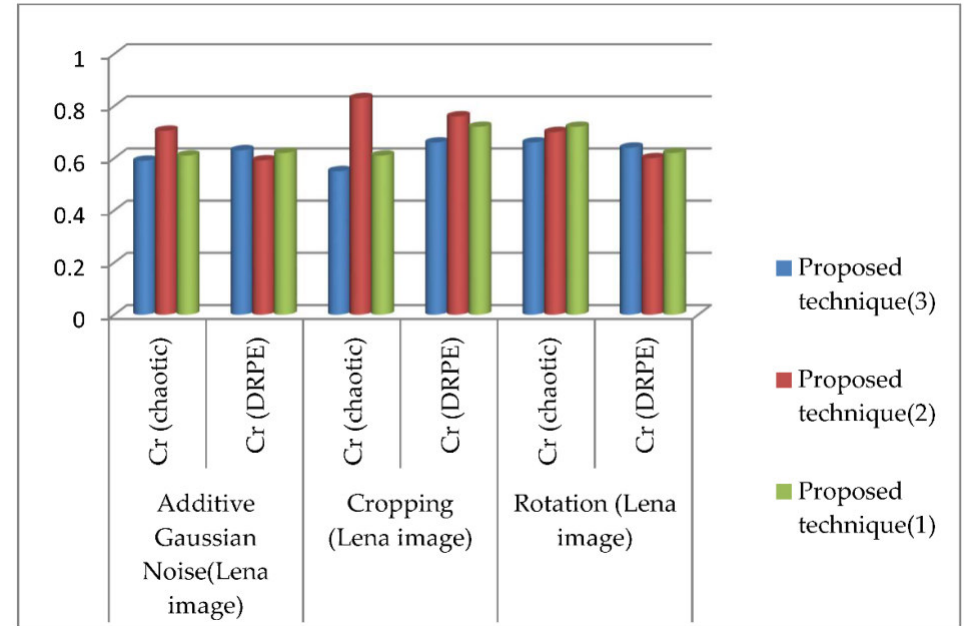
Figure 9. Comparison of Cr of recovered watermarks from gray Lena image for the three pro- posed techniques using DRPE and chaotic encryption after applying three types of attacks to water- marked